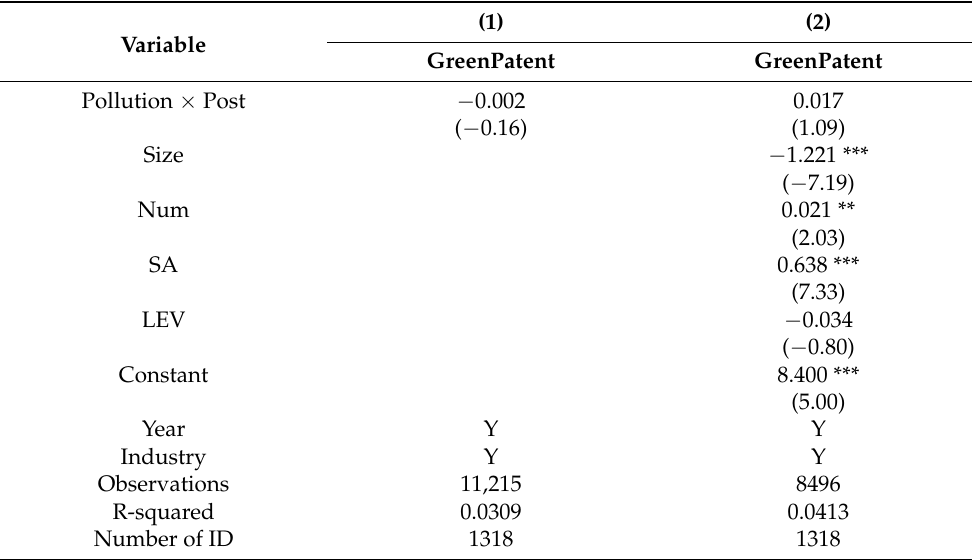
Table 7. Environmental regulation and corporate green innovation: placebo